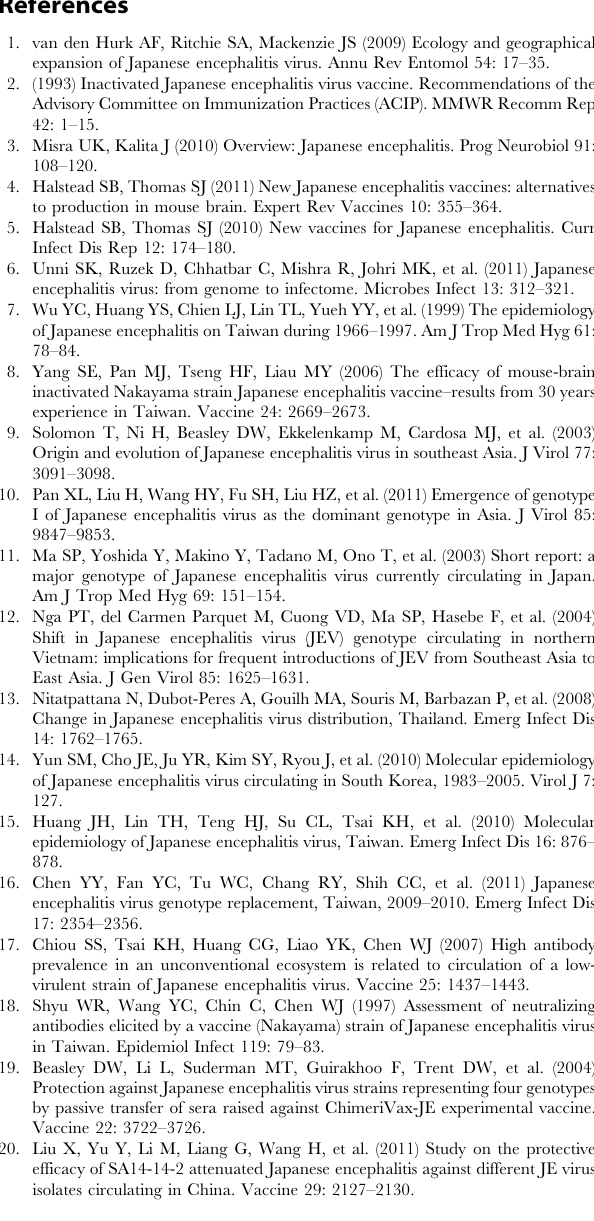
Figure S1 Selection of JEVs for neutralizing antibody assay. Four JEVs, GIII T1P1 (cluster II), GIII CJN (cluster I), GI TC2009-1 (cluster I), and GI YL2009-4 (cluster II), were evaluated using a panel of serum samples (N = 10 and 15 for panel A and B, respectively) by a plaque-reduction neutralization assay. The correlations of PRNT 50 were determined between (A) T1P1 and CJN or (B) TC2009-1 and YL2009-4. Number in black circle corresponding to the specimen number. Figure S2 Semi-ex vivo ADE experiment. The undiluted serum was pre-incubated with 1000 PFU of TC2009-1 virus and inoculated intraperitoneally into four suckling mice per serum.